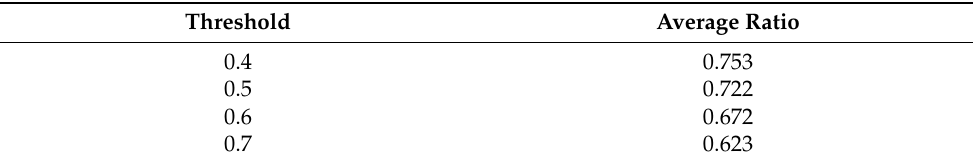
Table 2. Average ratio of bases that bind to other bases.